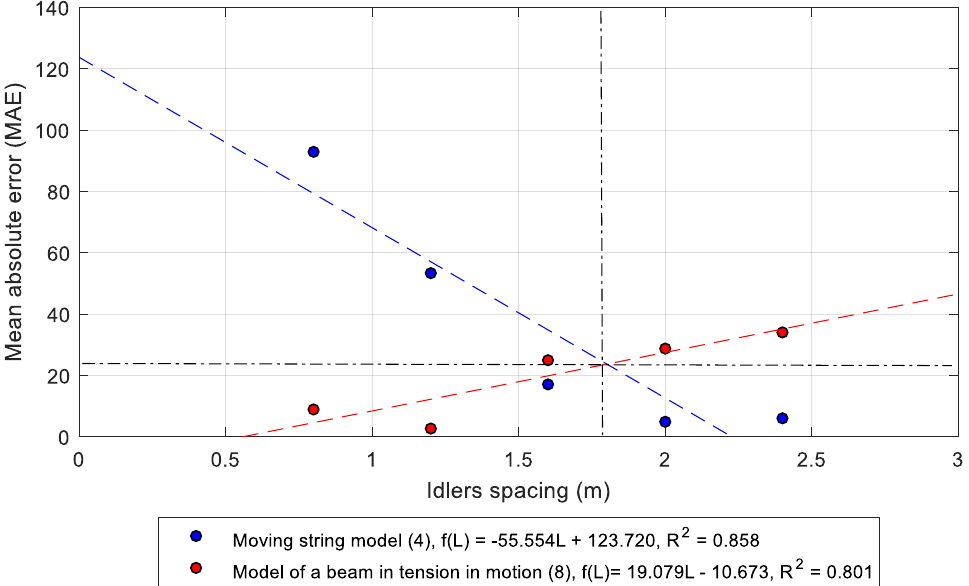
Figure 9. MAE in relation to the string model and to the beam model as a function of idler spacing, with indicated limit idler spacing.